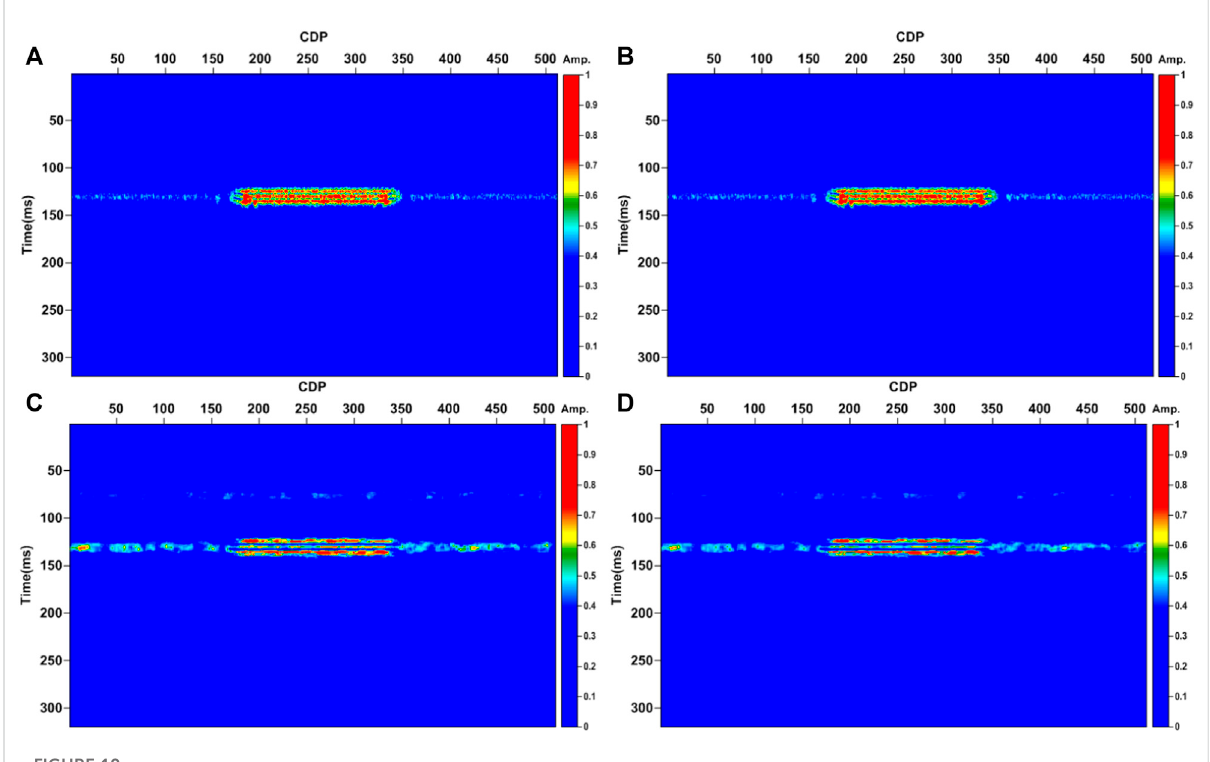
FIGURE 10 The absorption gradient section of the different channels using the proposed method for the noisy data in Figure 1B. (A) With channels of 3. (B) With channels of 6. (C) With channels of 400. (D) With channels of